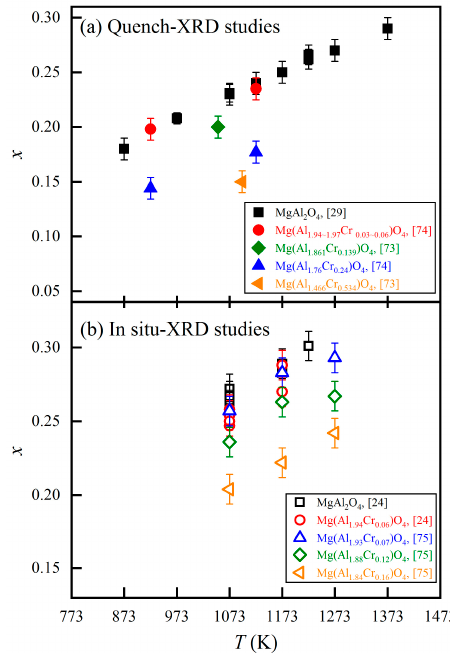
Figure 9. Correlations between temperatures ( T ) and x values of the MgAl 2 O 4 -rich spinels containing different amounts of Cr 3+ . ( a ) Data from quenched samples; ( b ) data from in situ measurements. The x values shown were all obtained by single-crystal X-ray diffraction.